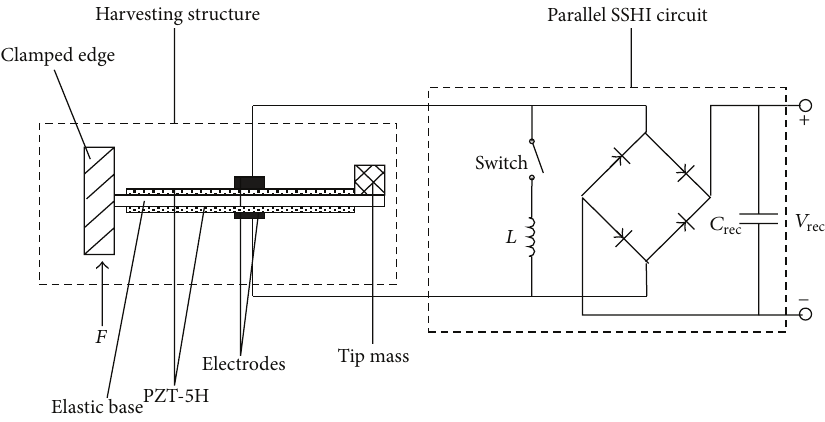
Figure 1: Structure of a PVEH system with a parallel SSHI